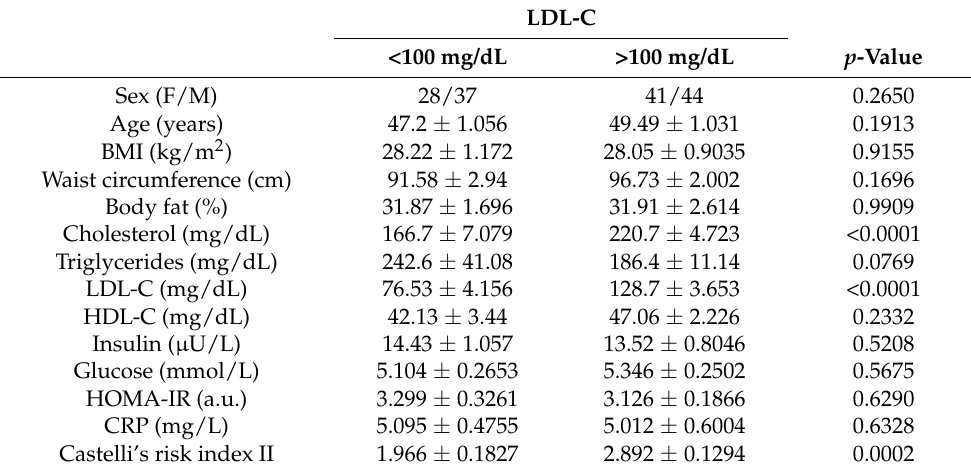
Table 1. Anthropometric and biochemical parameters of the study subjects. The study participants were divided into two groups of LDL-C concentration, as follows: subjects with optimal concentration of LDL-C ≤ 100 mg/dL, and individuals with high concentration of LDL-C > 100 mg/dL. Total cholesterol and Castelli’s atherogenic risk index significantly increased in patients with LDL-C greater than 100 mg/dL. Abbreviations: F, female; M, male; BMI, body mass index; LDL-C, low-density lipoproteins; HDL-C, high-density lipoproteins; HOMA-IR, homeostatic model assessment of insulin resistance; CRP, C-reactive protein; a.u., arbitrary units. Data are presented as mean ± standard deviation. Differences were considered significant when p <